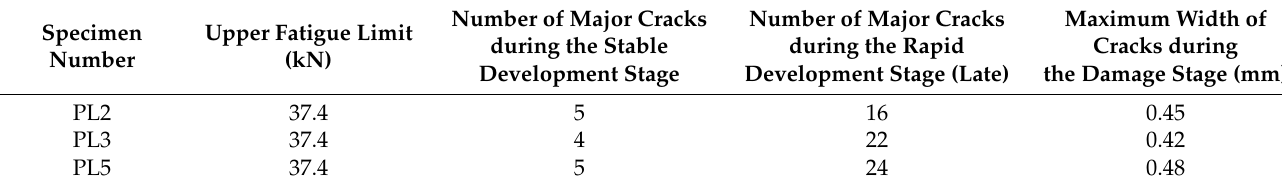
Table 4. Fatigue crack development in reinforced